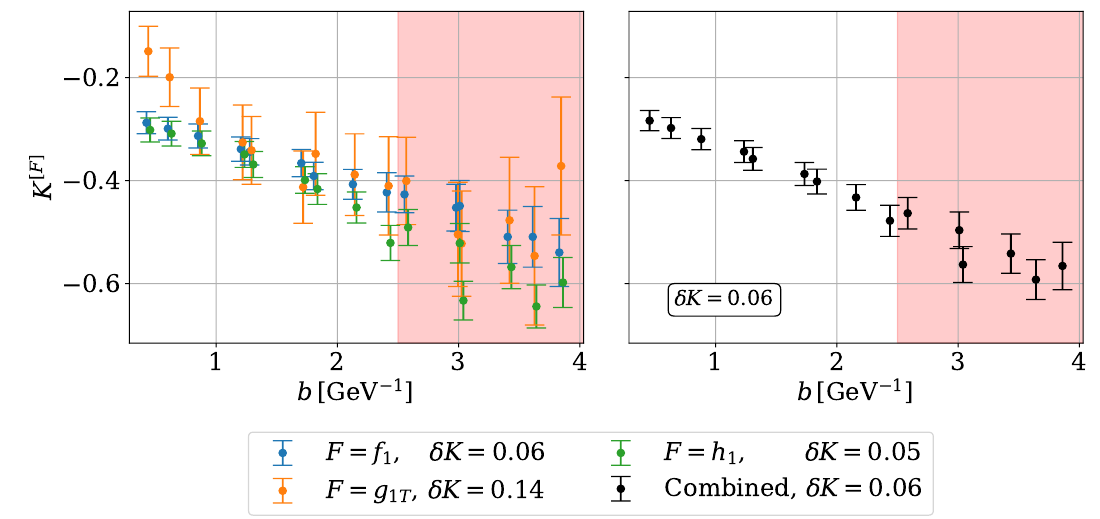
Figure 9 . Values for the CS kernel K ( b, µ = 2 GeV ) combined from the data in figure